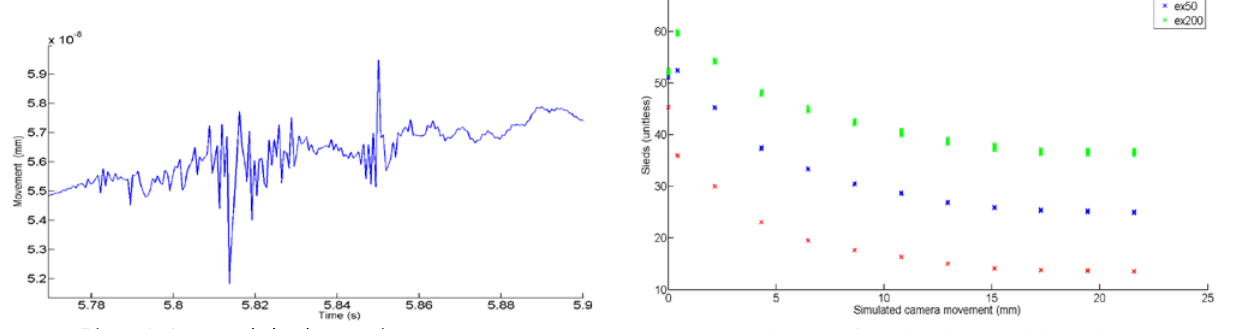
Figure 9. Camera shake due to mirror movement.